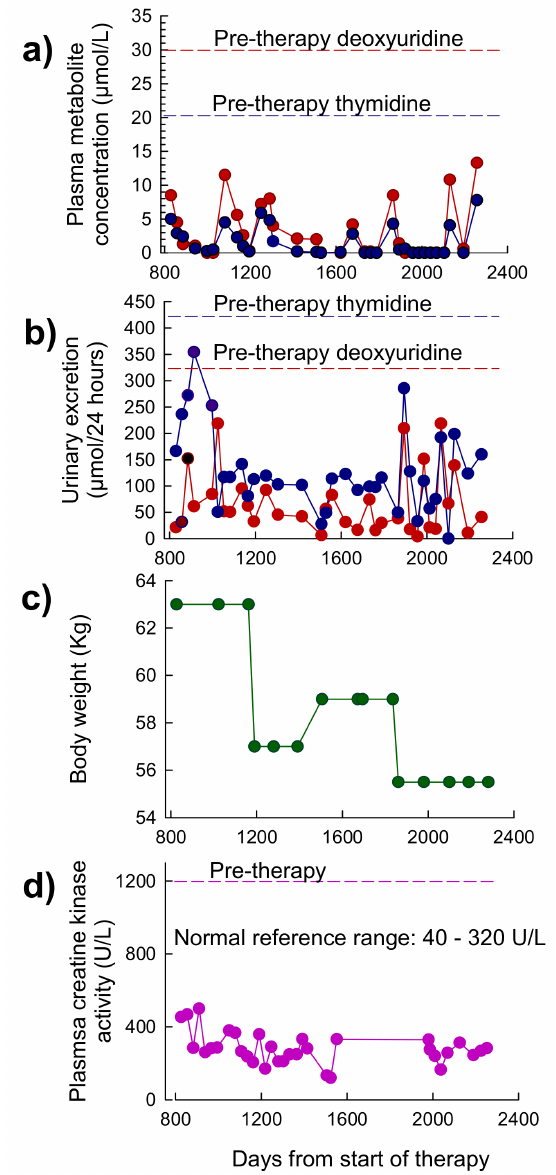
Figure 6. Plasma concentrations of deoxyribonucleosides, urinary excretion of deoxyribonucleosides, body weight and plasma creatine kinase in Patient 2 between 27 and 76 months of therapy with EE-TP. ( a ) Intra-cycle plasma thymidine and deoxyuridine concentrations were measured by UPLC. ( b ) Intra-cycle urinary excretions of thymidine and deoxyuridine were determined by measuring the concentration of the metabolites in 24 h urine collections. Red dotted lines represent pre-therapy deoxyuridine plasma concentration and urinary excretion, and blue dotted lines represent pre-therapy thymidine plasma concentrations and urinary excretion. ( c ) Patient body weight. ( d ) Plasma creatine kinase activity. Pink dotted line represents pre-therapy